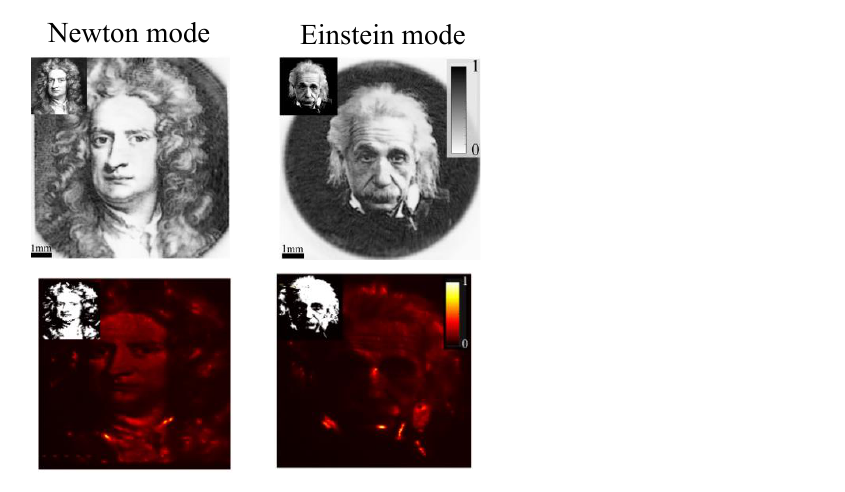
Figure 12. Incoherent Newton shaped beam and Einstein shaped beam; “Newton mode” and ”Einstein mode” intensity distributions (Adapted from an open-access source Ref. [90]).